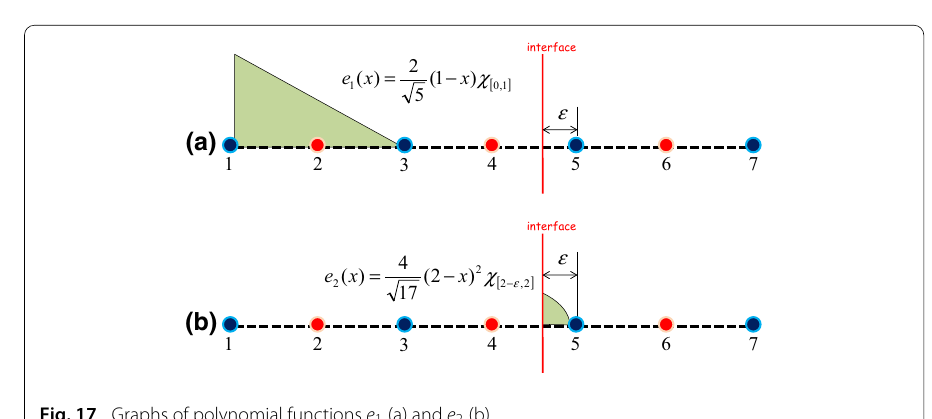
Fig. 17 Graphs of polynomial functions e 1 (a) and e 2